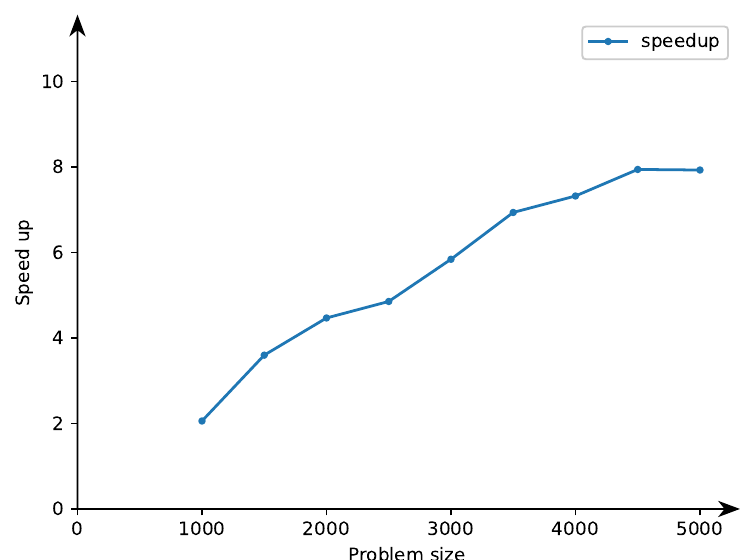
Figure 3. Speedup for Intel Xeon X5570 v3 and 32 OpenMP threads.